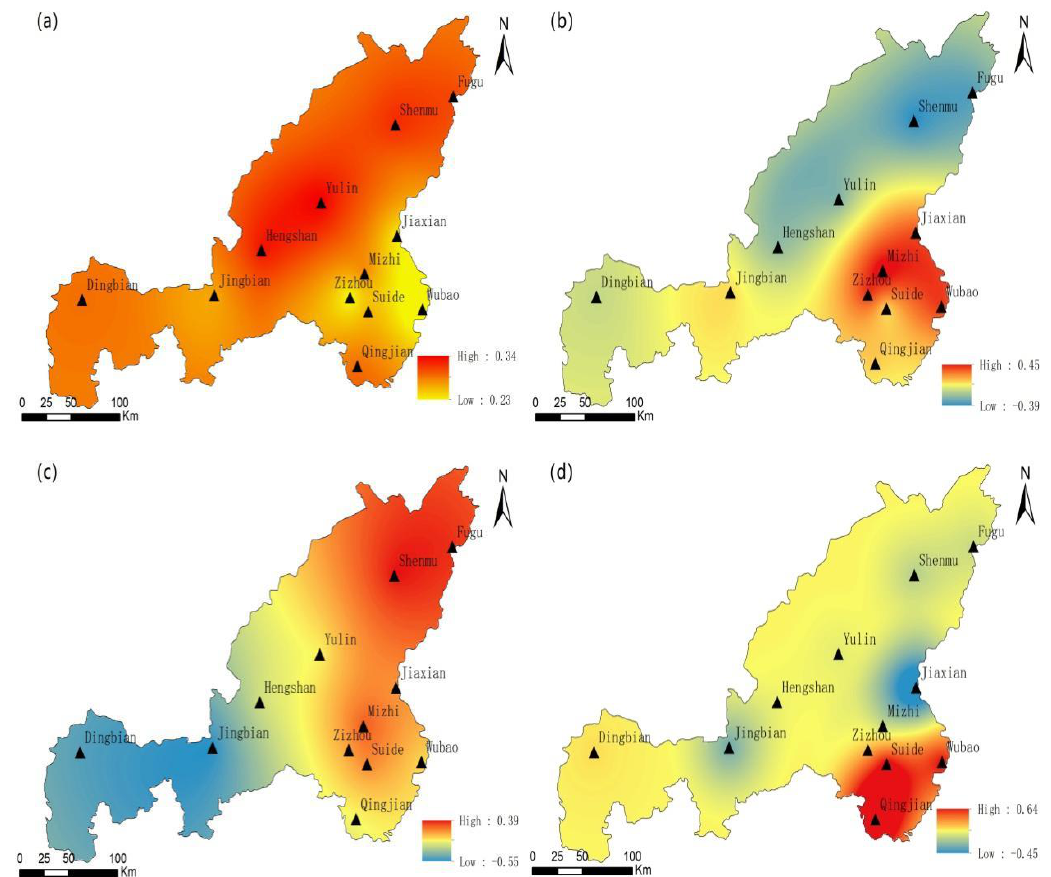
the wettest, while the rest of the region was the driest. The linear trend of PC1 is positive, but not